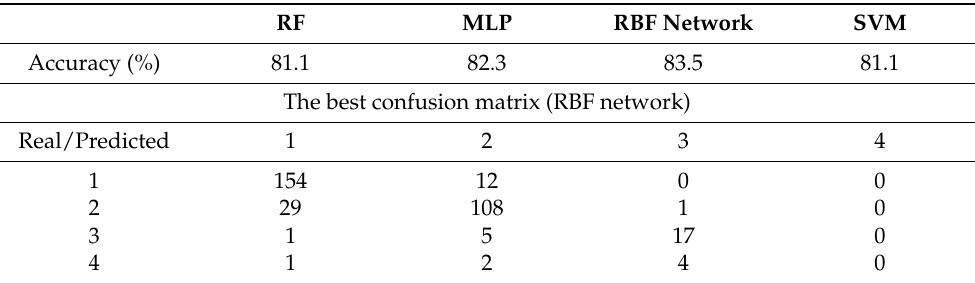
Table 4. The accuracies and the best confusion matrix for the classification analysis of LOS, measured in weeks.